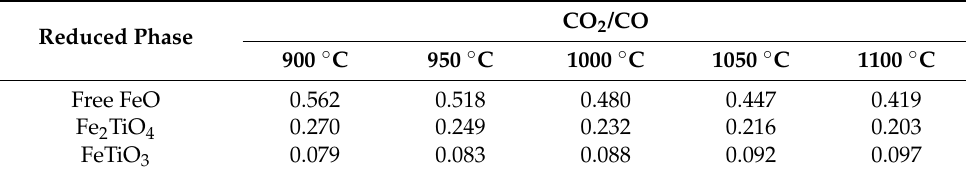
Table 7. CO 2 /CO value required for different phases in 900–1100 ◦ C.